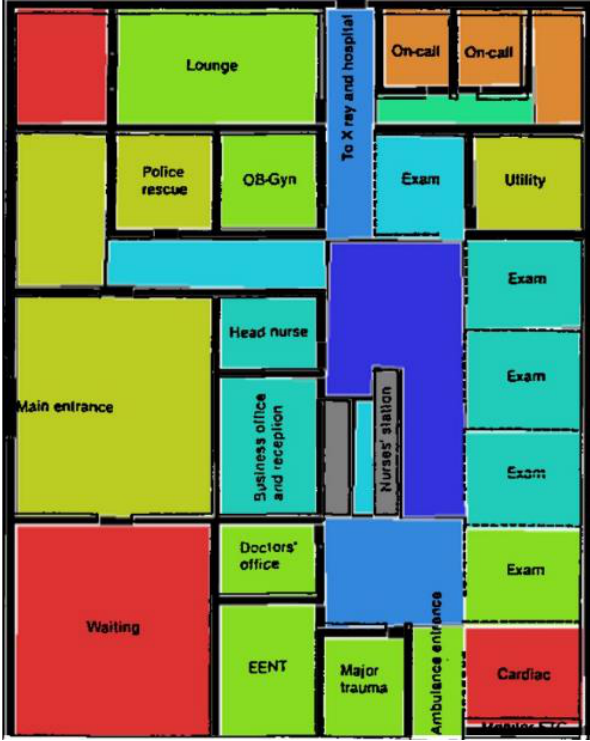
Fig. 7. Convex map analysis of arena type emergency